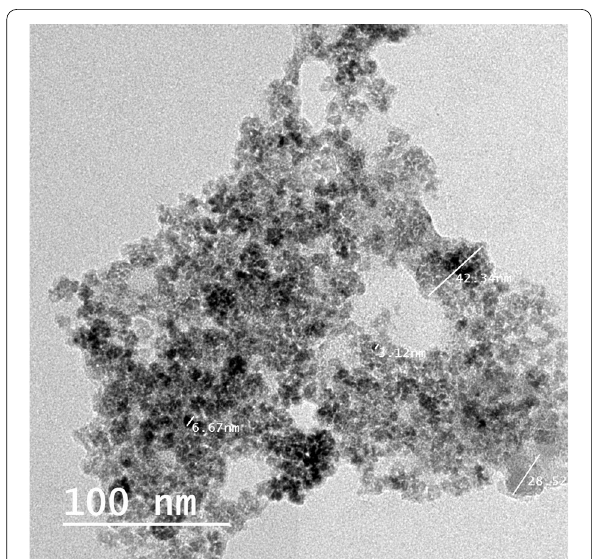
Fig. 2 MNPs’ dispersion within dextran matrix explained by TEM